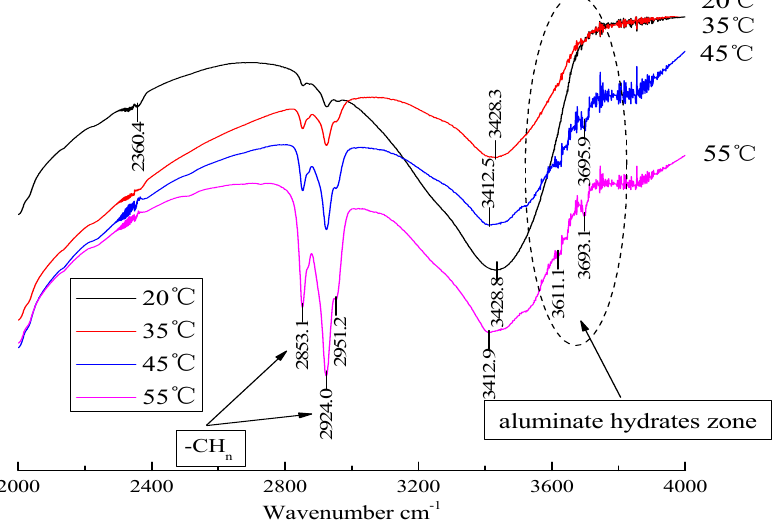
Figure 12. IR analysis of CAM-I hydrates at different temperatures (hydration for 5 min).